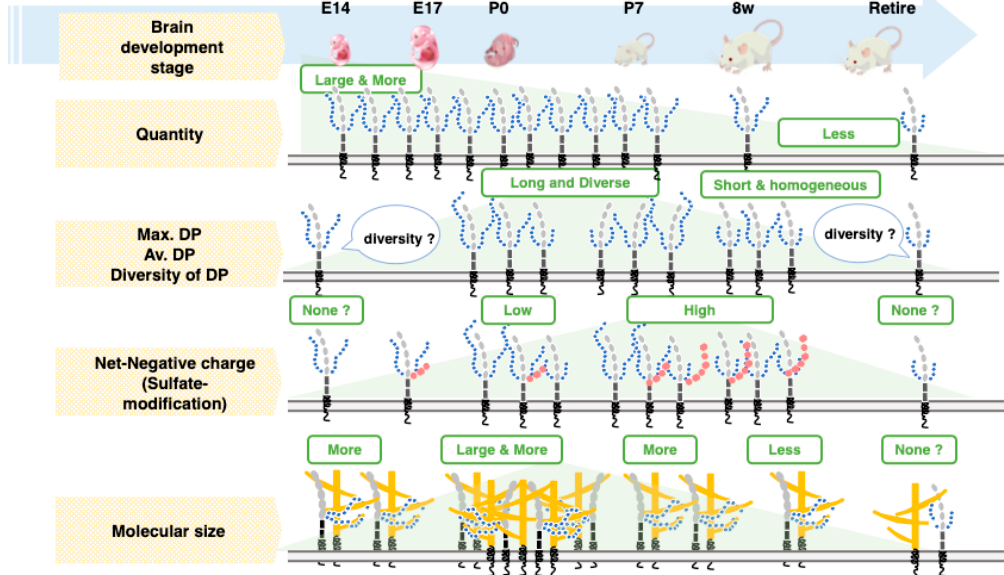
Figure 10. The quantity and quality of polySia and features of polySia–NCAM in brain development. polySia–NCAM is highly regulated in both quantity and quality (DP, net negative charge, and size) during brain development. The quantity of polySia–NCAM is decreased from E14 until retired, although re-increased in retired mice in the native PAGE technique. The DP of polySia is postnatally decreased during development; however, the net negative charge and molecular size of polySia are not always consistent with the change of DP but appear to be unique to the developmental stages. PolySia or polySia–NCAM is reported to have a relationship with mental disorders, such as actually contains mutations or significant SNPs that are statistically associated with mental disorders,